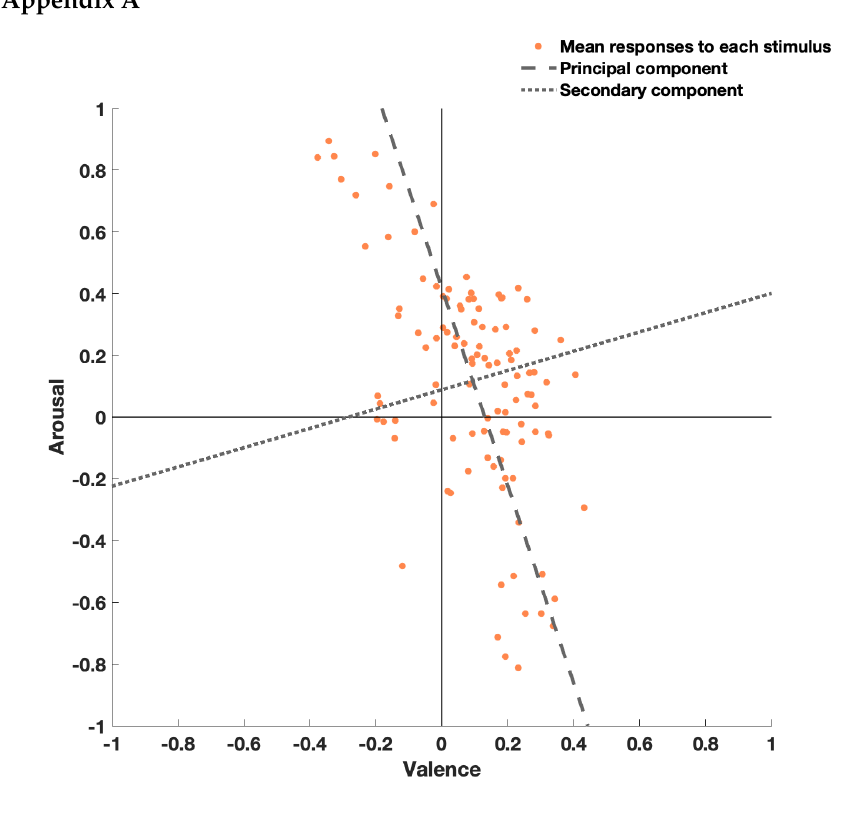
Figure A1. Mean responses of participants to each stimulus in Experiment 1, including principal and secondary components of principal component analysis.